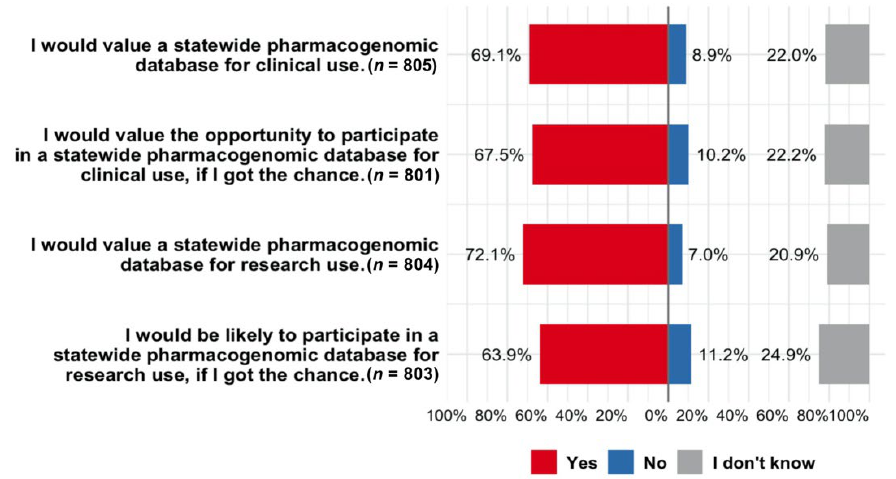
Figure 5. Acceptability of a statewide pharmacogenomic shelter for clinical and research purposes.